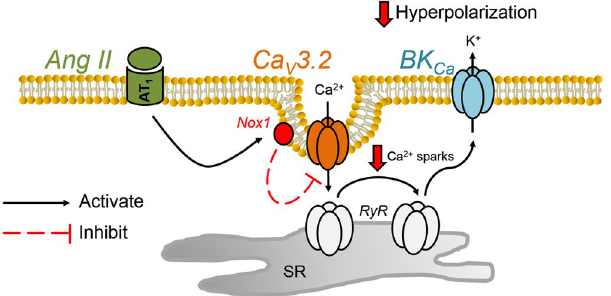
Figure 7. Schematic diagram highlighting the mechanism of Ang II suppression of Ca V 3.2 channels and its functional impact on the BK Ca mediated feedback in cerebral